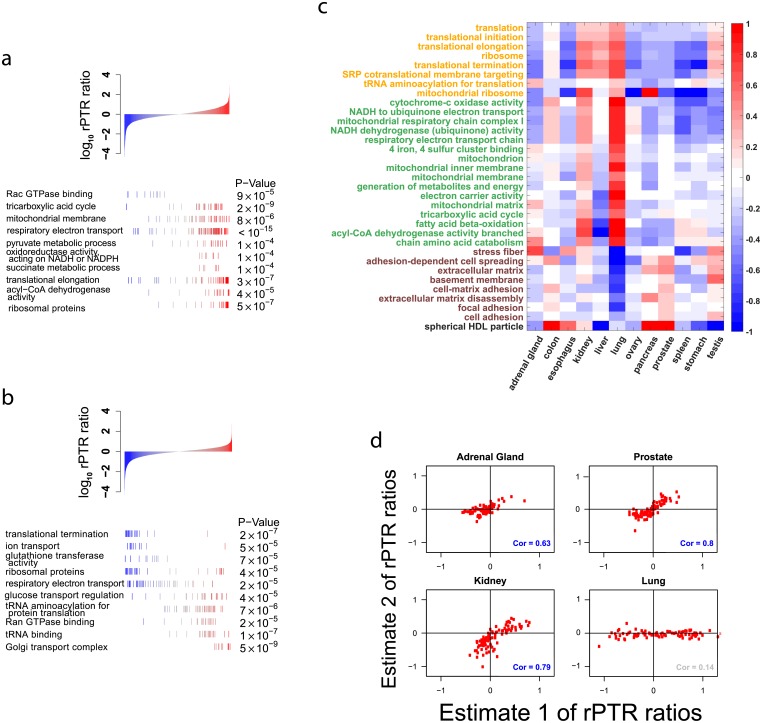
Concerted variability in the relative protein-to-RNA (rPTR) ratio of functional gene-sets across tissue-types.(a) mRNAs coding for the ribosomal proteins, NADH dehydrogenase and respiratory proteins have higher protein-to-mRNA ratios in kidney as compared to the median across the other 11 tissues (FDR < 1%). In contrast mRNAs genes functioning in Rac GTPase binding have lower protein-to-mRNA ratios (FDR < 1%). (b) The stomach also shows significant rPTR variation, with low rPTR for the ribosomal proteins and high rPTR for tRNA-aminoacylation (FDR < 1%). (c) Summary of rPTR variability, as depicted in panel (a-b), across all tissues and many gene ontology (GO) terms. Metabolic pathways and functional gene-sets that show statistically significant (FDR < 1%) variability in the relative protein-to-mRNA ratios across the 12 tissue types. All data are displayed on a log10 scale, and functionally related gene-sets are marked with the same color. (d) The reproducibility of rPTR estimates across estimates from different studies is estimated as the correlation between the median rPTRs for GO terms showing significant enrichment as shown in panels (a-c). See Methods, S2 and S3 Figs.